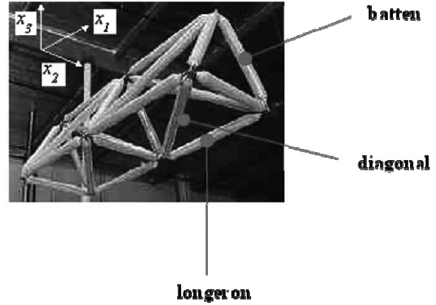
Fig. 1. Fundamental truss element of an in fl atable truss (curtsey of